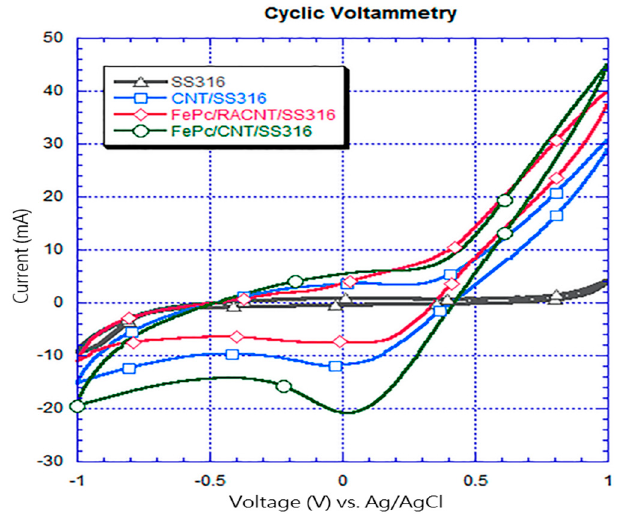
Figure 9. Measurement chart of cyclic voltammetry current-voltage.